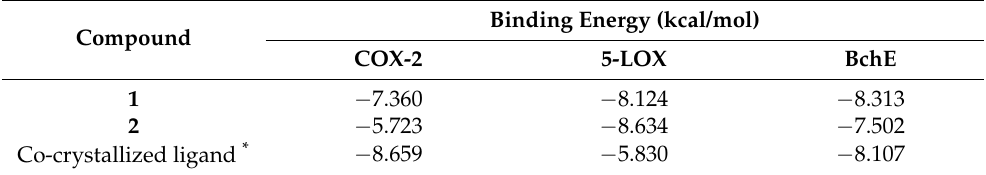
Table 4. Docking scores of the isolated compounds ( 1 and 2 ) against COX-2, 5-LOX, and BchE enzymes using AutoDock Vina